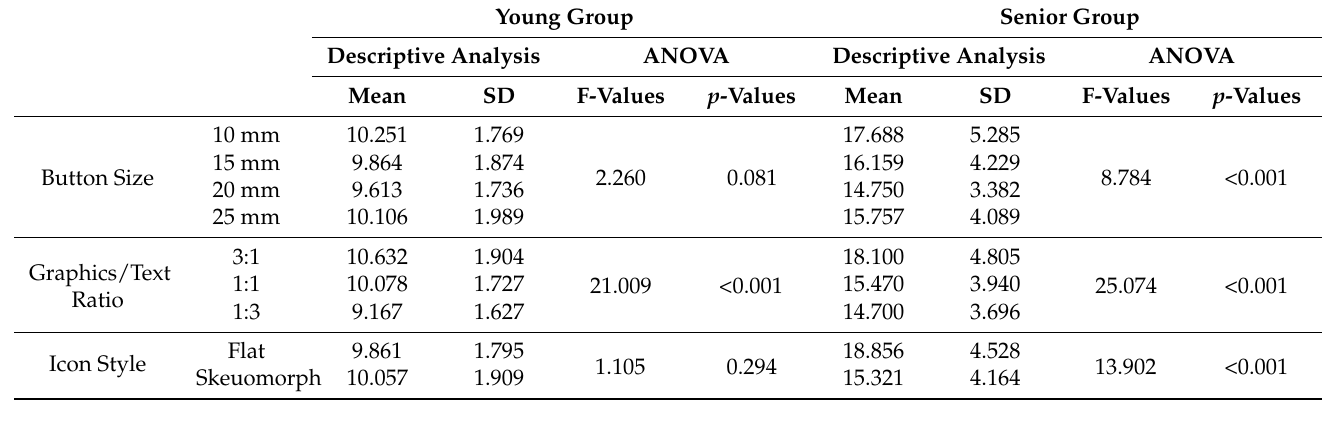
Table 3. Main effects of button size, graphics/text ratio, and icon style on task completion time (s).